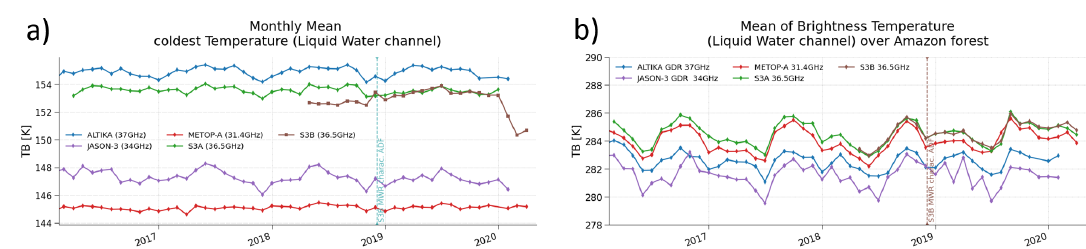
Figure 11. Monitoring of ( a ) Cold reference and ( b ) Hot reference for 23.8 GHz channel of S3A and S3B.